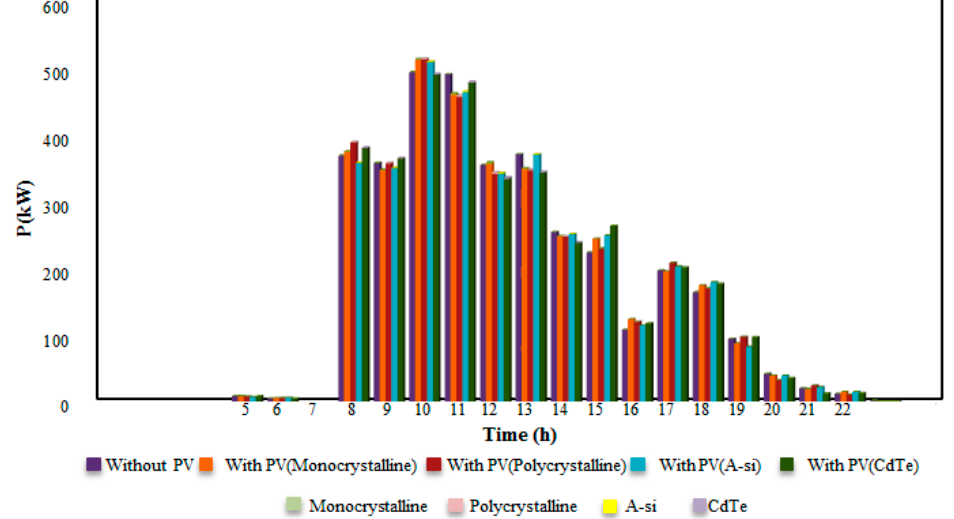
Figure 5. Power supplied by DSO and PV panel in February.